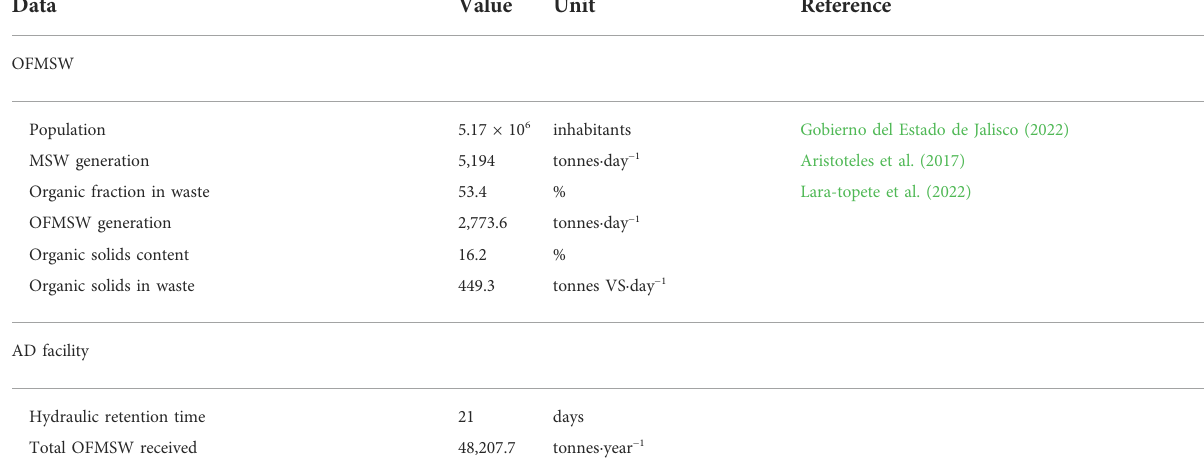
TABLE 5 Estimations of power production, economic and environmental bene fi ts in the MAG through the AD of